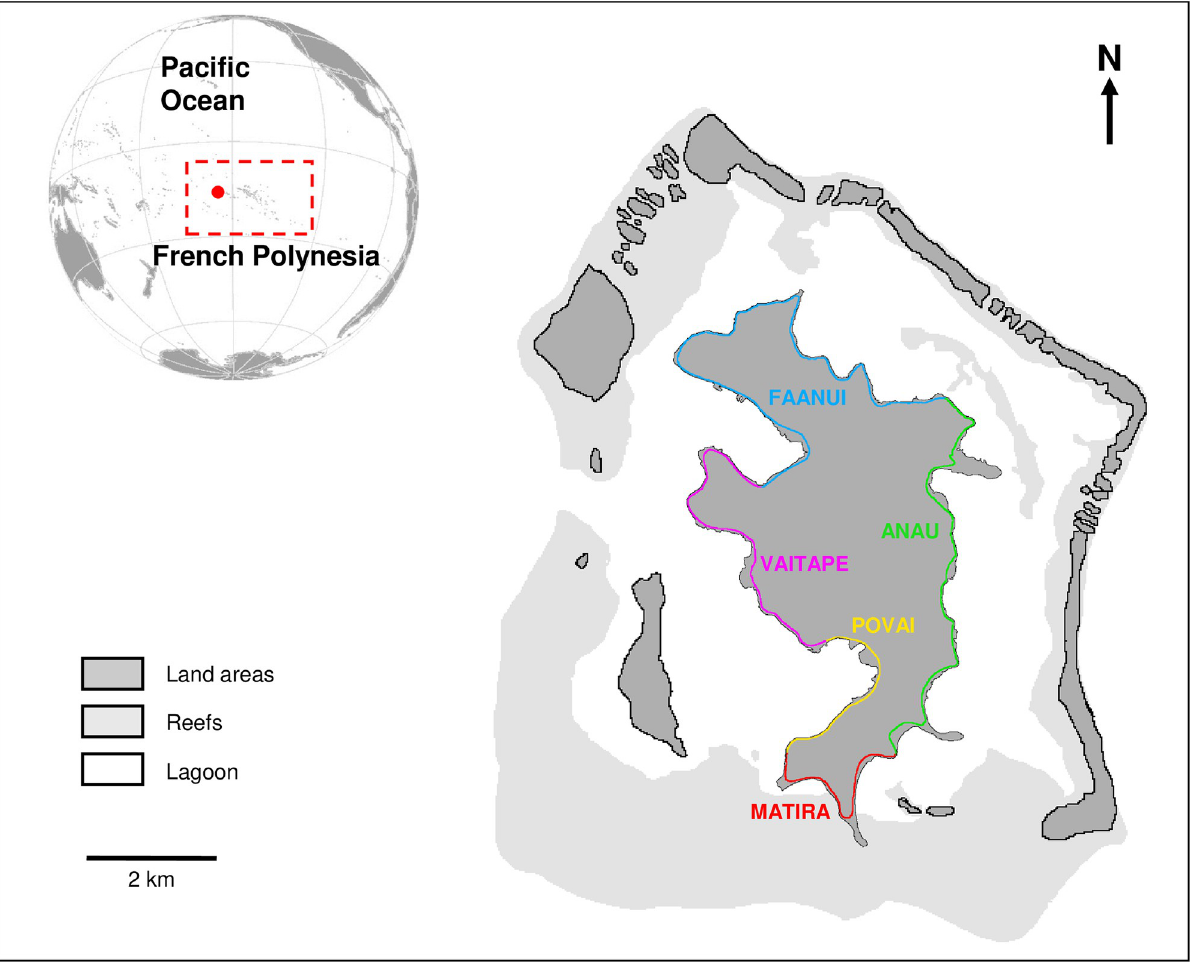
Fig 1. Map of Bora-Bora showing the main road across the five different districts where roadside stalls were surveyed. Stands are represented by red dots. Vaitape is the main village on the island and the most touristic part of Bora-Bora along with Povai and Matira. Anau and Faanui are more rural parts of the island. There are no sales of land or sea products on the different islets surrounding the main island of Bora-Bora. The only road is the one that runs along the coast all around the island. Reprinted from an aerial photograph under a CC BY license, with permission from CRIOBE, original copyright